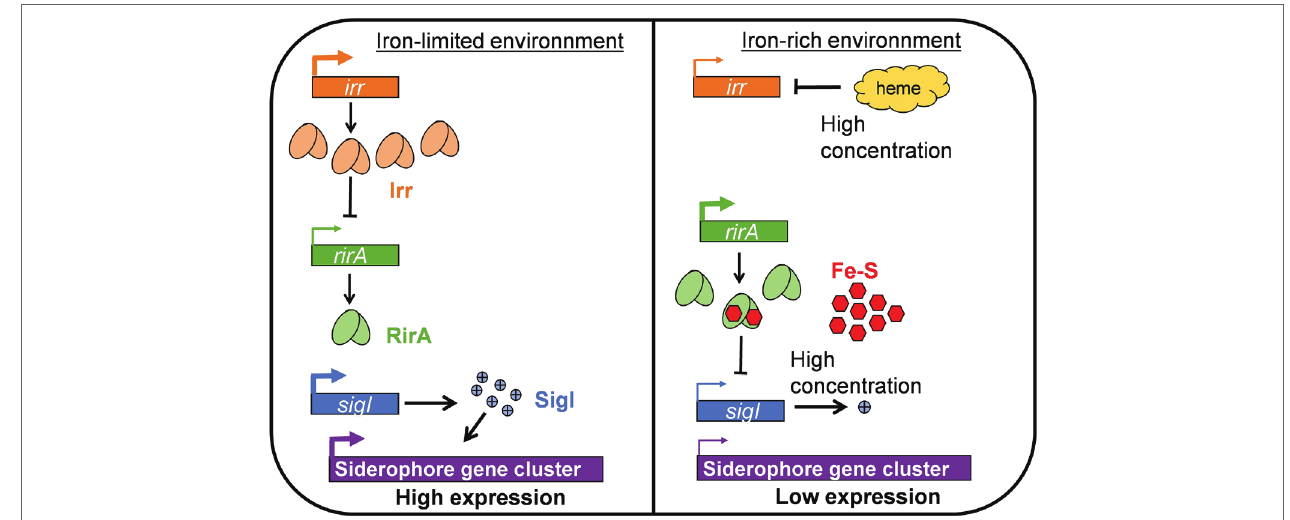
FIGURE 2 | Model of the regulation of siderophore gene cluster expression according to iron availability. In an iron-limited environment, due to the low heme and Fe-S concentrations, the Irr protein is abundant and represses rirA . Consequently, SigI, which is under the negative control of RirA, is expressed and can induce siderophore synthesis. In an iron-rich environment, Irr is negatively regulated by the high heme concentration. In these conditions, RirA is abundant and its binding to Fe-S allows for the repression of sigI, which leads to the very low expression of siderophore biosynthesis